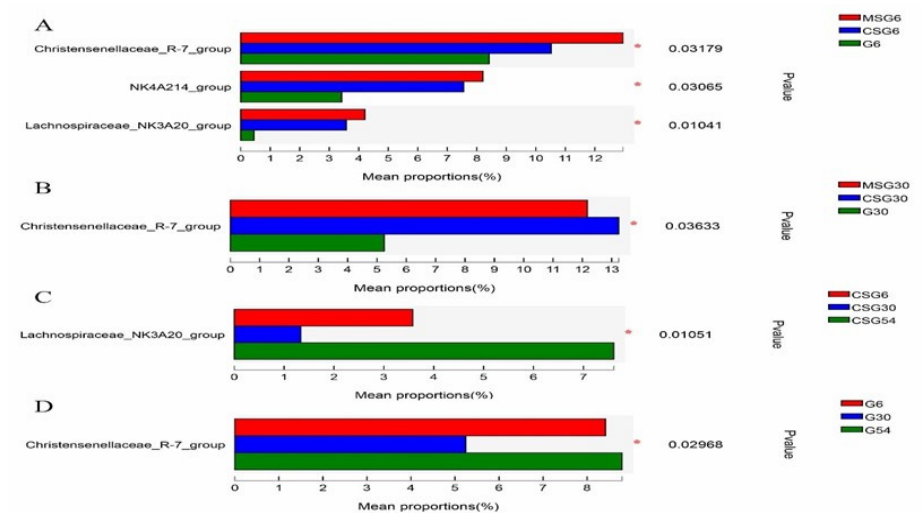
Figure 5. Difference in the relative abundance of various genera according to one-way ANOVA test; * p < 0.05. A: Comparison of dominant genera in 6M with different dietary treatments; B: Comparison of dominant genera with different dietary treatments in 30M; C: Comparison of dominant genera with different ages in the CSG group; D: Comparison of dominant genera with the different ages in the G group.